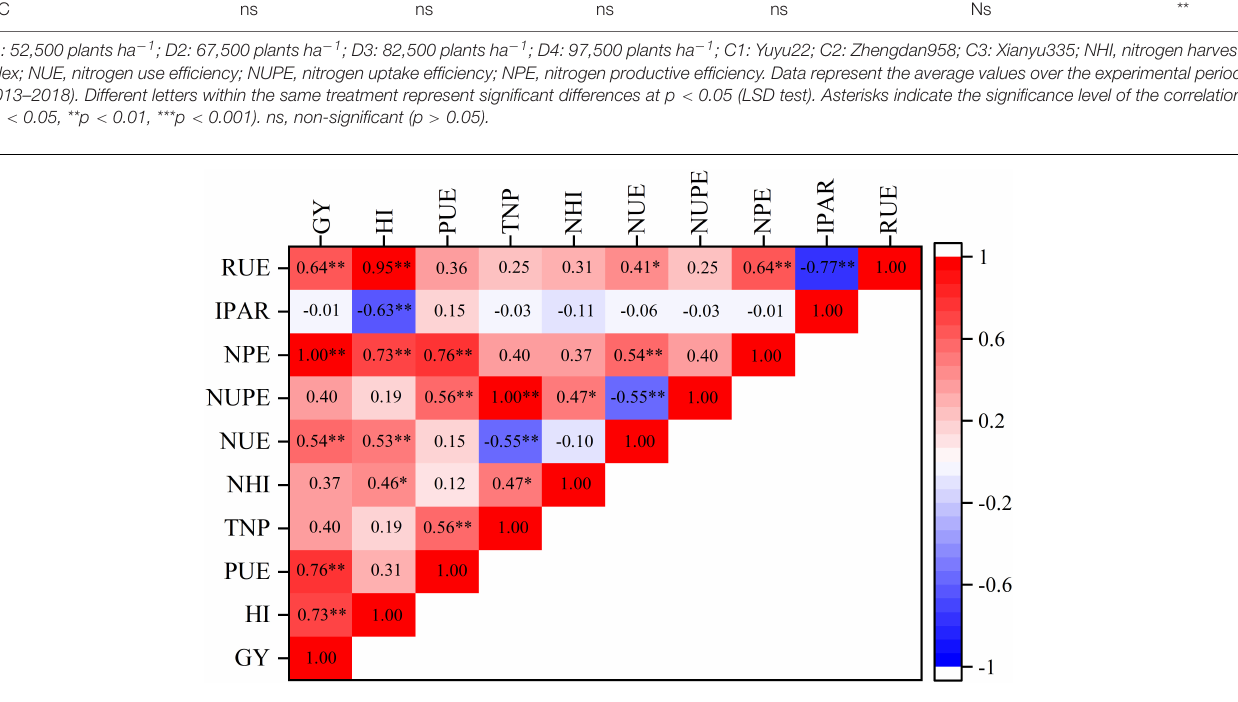
FIGURE 5 | Correlation coefficients of maize yield and resource use efficiency. GY, grain yield; HI, harvest index; PUE, precipitation use efficiency; TNP, total nitrogen uptake; NHI, nitrogen harvest index; NUE, nitrogen use efficiency; NUPE, nitrogen uptake efficiency; NPE, nitrogen productive efficiency; IPAR, intercepted photosynthetically active radiation; RUE, radiation use efficiency. Asterisks indicate the significance level of the correlation ( ∗ p < 0.05, ∗∗ p < 0.01, ∗∗∗ p < 0.001). ns, non-significant ( p >